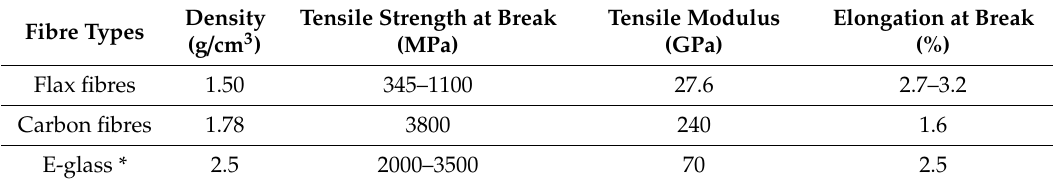
Table 1. Comparative physical and mechanical properties of flax and carbon fibre